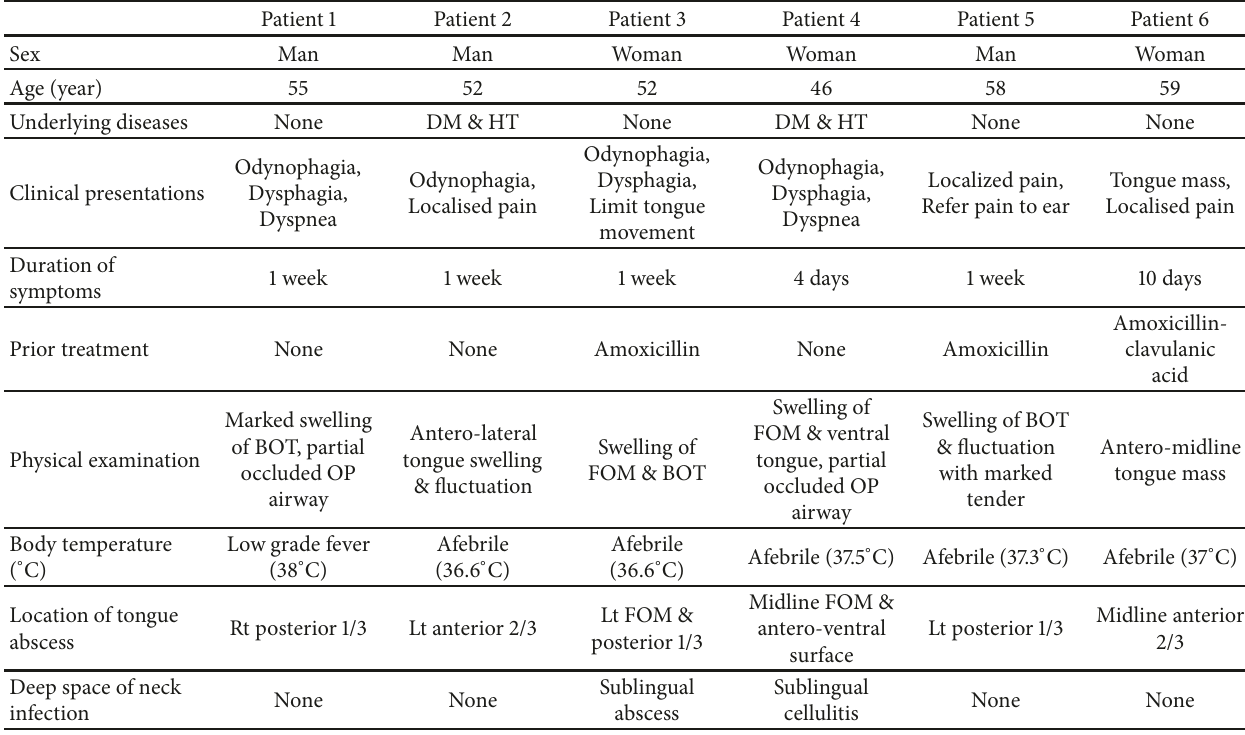
Table 1: Demographic data.